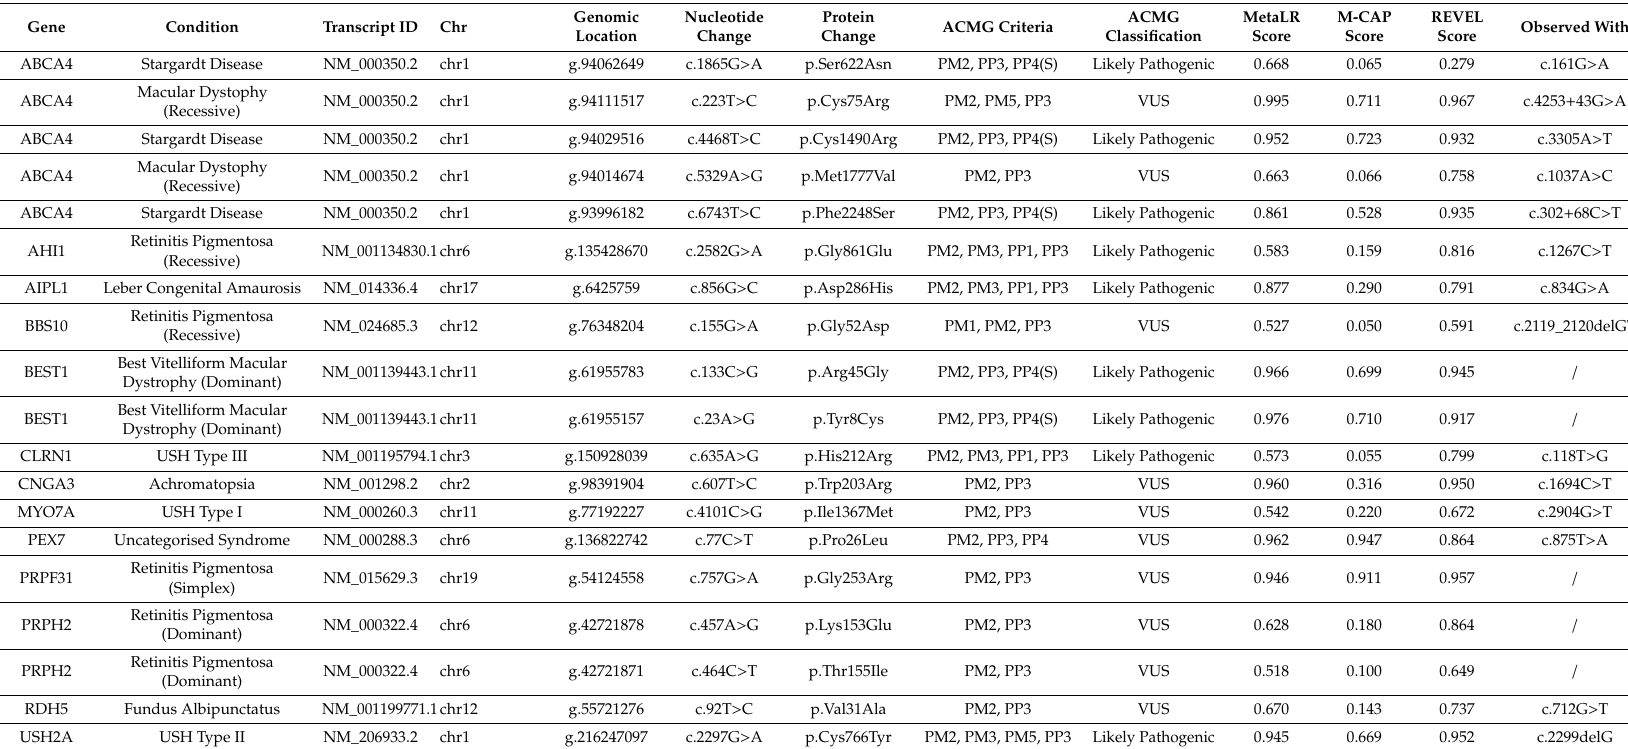
Table 2. List of 19 novel missense variants discovered in Target 5000. This table does not include novel structural variants reported below. To the best of our knowledge, mutations listed here have not been previously associated with an IRD. American College of Medical Genetics and Genomics (ACMG) guidelines have been applied to all variants [21], with modifications made in accordance with recommendations by Romanet et al. [23]. (S): reclassified as strong evidence. VUS: Variant of unknown